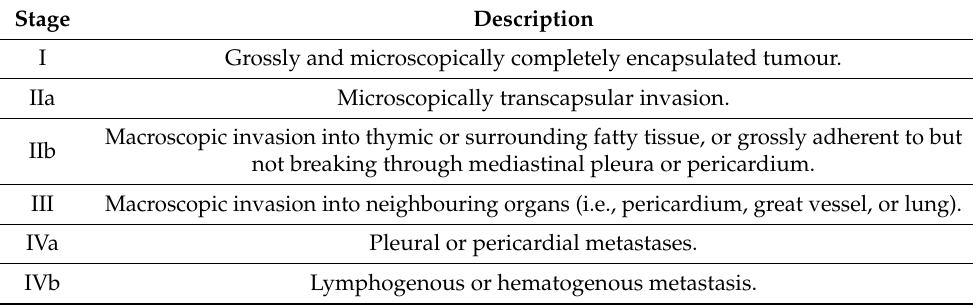
Table 2. Masaoka–Koga staging system for thymoma